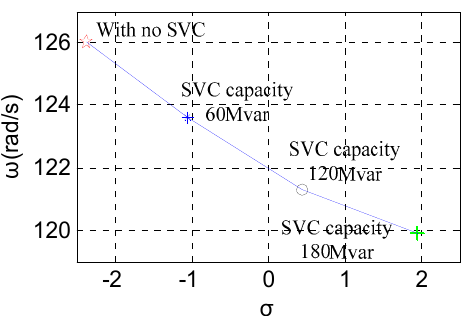
Figure 8. Variation trend of eigenvalues of the main electromagnetic oscillation mode with capacities of SVCs (1000 km transmission line).